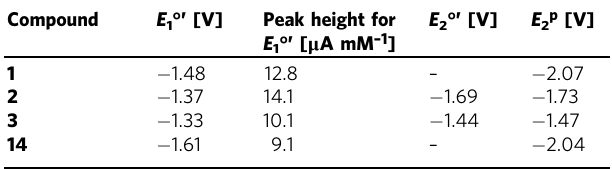
Table 1 Electrochemical data — reductions